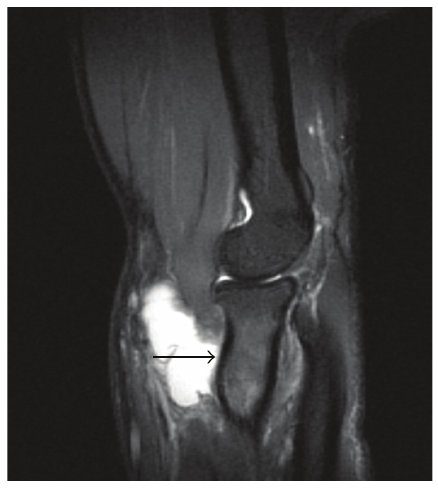
Figure 4: Sagittal STIR image of the elbow demonstrating a large exposed area of the anterior radial cortex where the supinator muscle has been stripped away (solid black